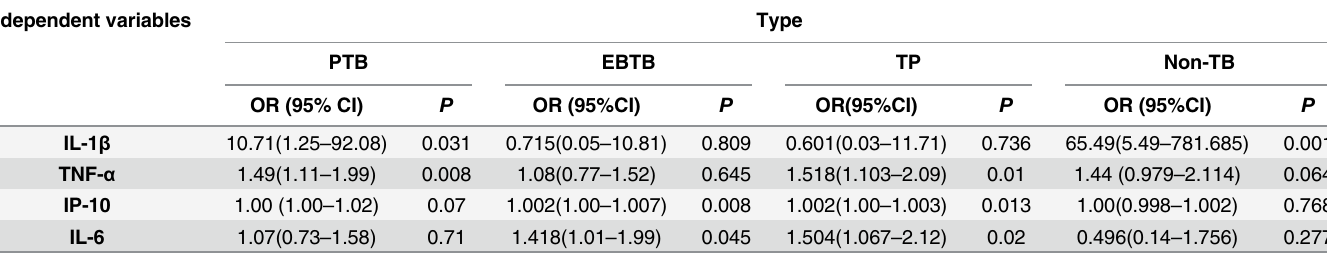
Table 3. Association of patient cytokine expression profiles and disease. Independent